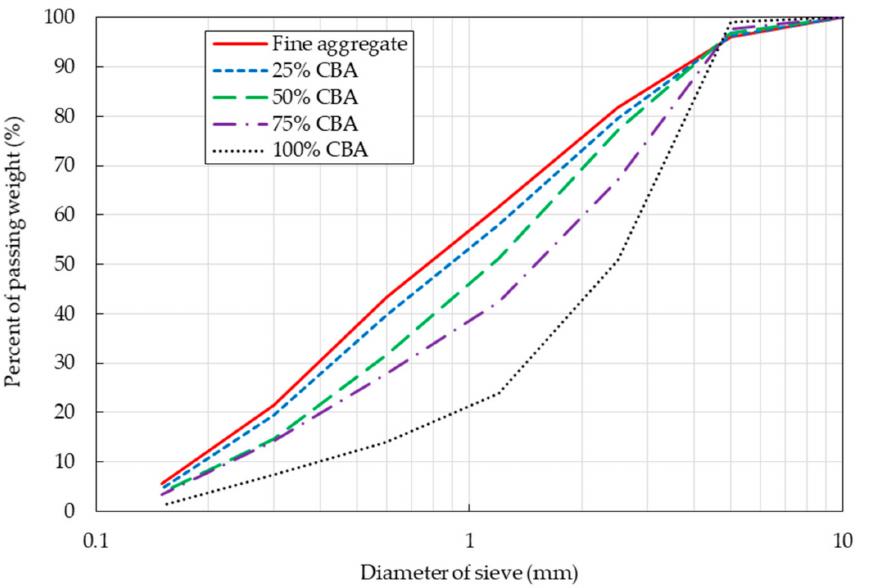
Figure 2. Sieve analysis of the combinations with CBA and natural fine aggregate at different CBA